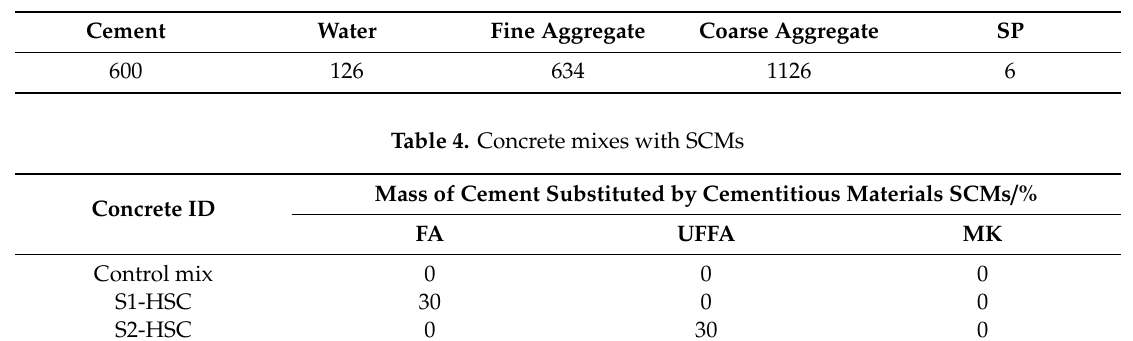
Table 3. Mixture proportion of control concrete / (kg · m − 3 )